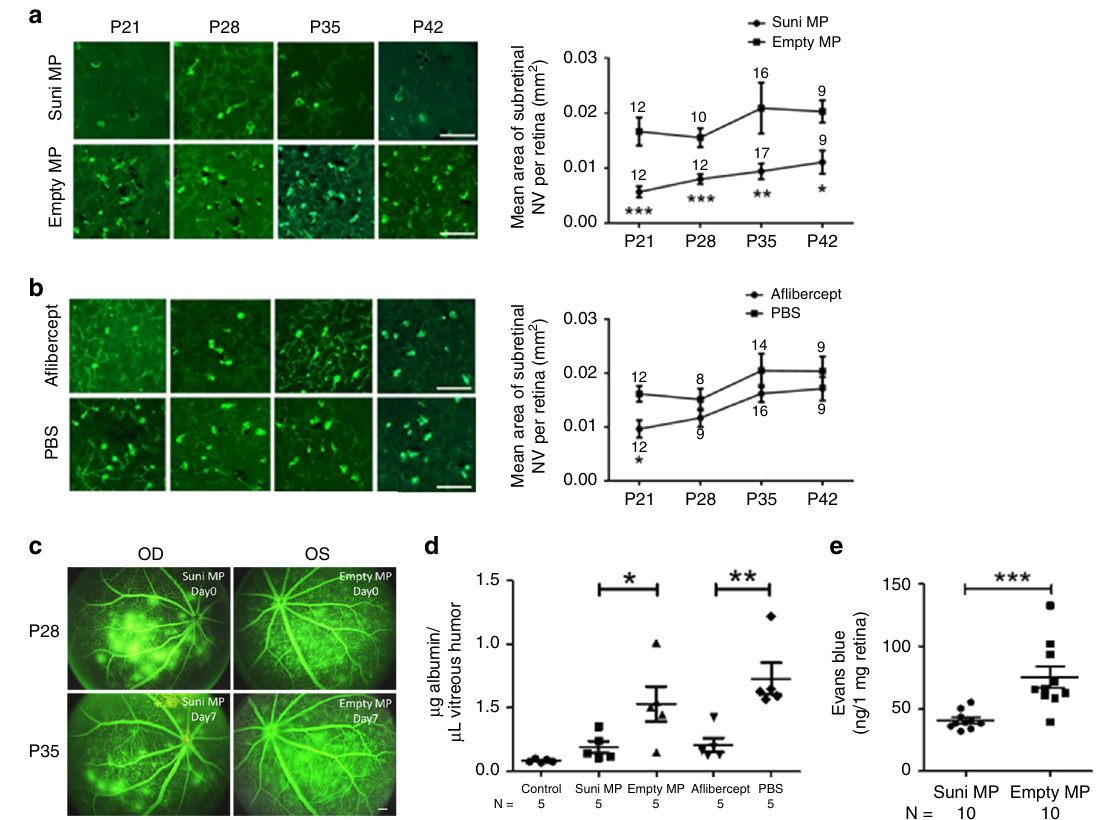
Fig. 4 Sunitinib MPs suppress murine type 3 choroidal NV substantially longer than a fl ibercept. At P14, rho/VEGF mice had intravitreous injection of MP containing 10 µ g sunitinib (Suni MP) in one eye and empty MPs in the other eye or 40 µ g of a fl ibercept in one eye and PBS in the other eye. At P21, P28, P35, or P42, mice were euthanized and retinal fl at mounts were stained with FITC-labeled GSA lectin. The total area of subretinal NV per retina was measured by image analysis. Compared with empty MP-injected eyes, those injected with Suni MPs had signi fi cantly lower mean (±SEM) area of NV per retina at each time point ( a ). Compared with PBS-injected eyes, those injected with a fl ibercept had signi fi cantly lower mean (±SEM) area of NV per retina at P21, but not P28, P35, or P42 ( b ). At P28, rho/VEGF mice had fl uorescein angiography showing severe leakage resulting in large collections of extravascular fl uorescein ( c top row). One eye was injected with MP containing 10 µ g of sunitinib or 40 µ g of a fl ibercept and the other with empty MPs or PBS and after 1 week repeat fl uorescein angiography showed less leakage in sunitinib MP-injected eyes, but not empty MP-injected eyes ( c bottom row, scale bar = 100 µ m). Vitreous samples were obtained and the mean (±SEM) concentration of vitreous albumin measured by ELISA was signi fi cantly less in Suni MP-injected eyes vs. empty MP-injected eyes and similar to untreated control eyes ( d ). Mean vitreous albumin was also signi fi cantly less in a fl ibercept-injected eyes vs. PBS-injected eyes ( d ). The experiment described in ( c ) and ( d ) was repeated in P28 rho/VEGF mice using a different outcome measure, leakage of intravascular Evans Blue dye into the retina as described in Methods. e The mean (±SEM) concentration of Evans Blue dye in the retina was signi fi cantly less in eyes injected with sunitinib MP compared with those injected with empty MP. Number of animals used in each group are shown in the graph or below the graph. * p < 0.05; ** p < 0.01; *** p < 0.001 by Mann Whitney from corresponding control. Bar = 100 µ m. Source data are provided as a Source Data fi immunoblots of retinal homogenates from sunitinib MP-injected eyes had signi fi cantly greater rhodopsin kinase/actin ratio com- pared with those from empty MP-injected eyes, but there was no difference between a fl ibercept- and PBS-injected eyes (Fig. 5c, d). Sunitinib MPs reduce VEGF-induced leukostasis/ nonperfu- sion . VEGF plays a critical role in the pathogenesis of diabetic retinopathy as well as NVAMD. Increased levels of VEGF in the retina cause leukostasis and closure of retinal vessels exacerbating retinal hypoxia 41 , which is strongly associated with progression of intravitreous injection of 200 ng of VEGF in each eye one week a fl ibercept in one eye and an equivalent mass of empty MPs or